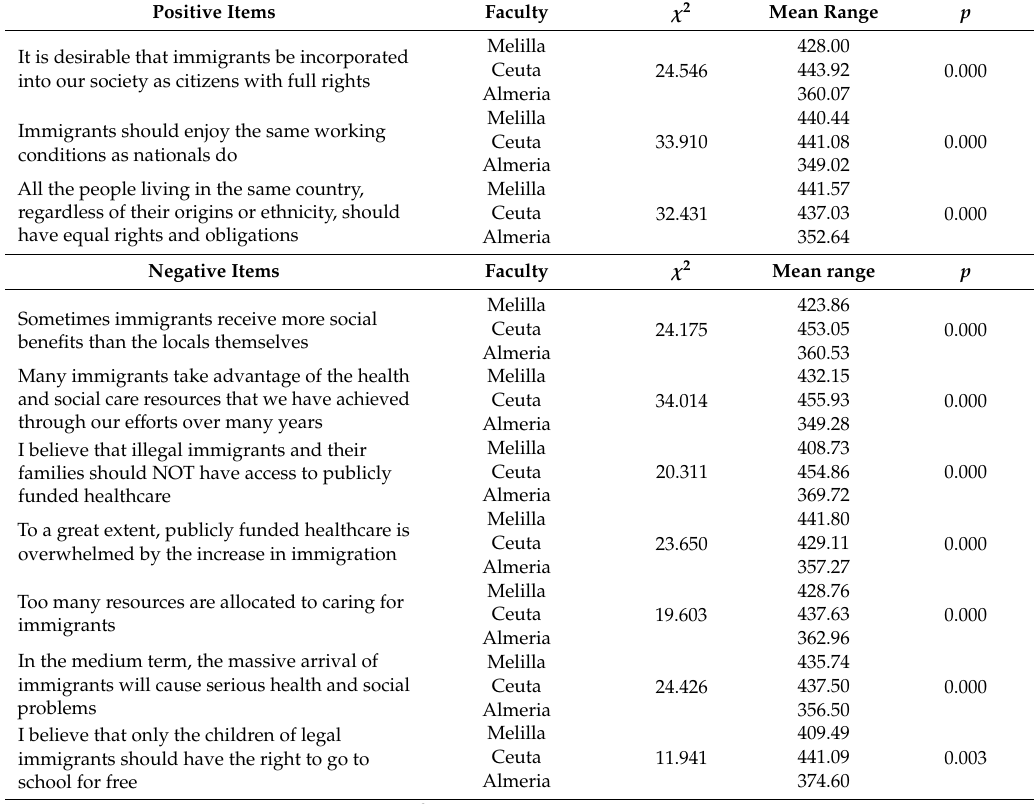
Table 5. Immigration and Social Rights. Positive and negative attitudes according to the variable: